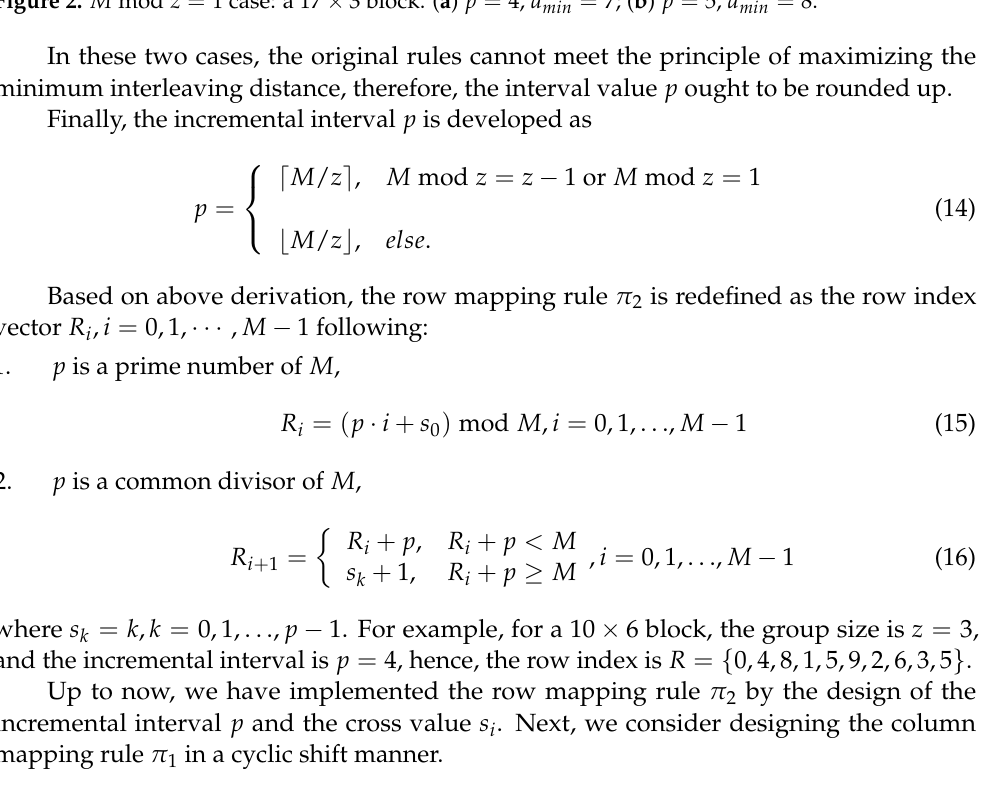
Figure 2. M mod z = 1 case: a 17 × 3 block. ( a ) p = 4, d min = 7; ( b ) p = 5, d min =